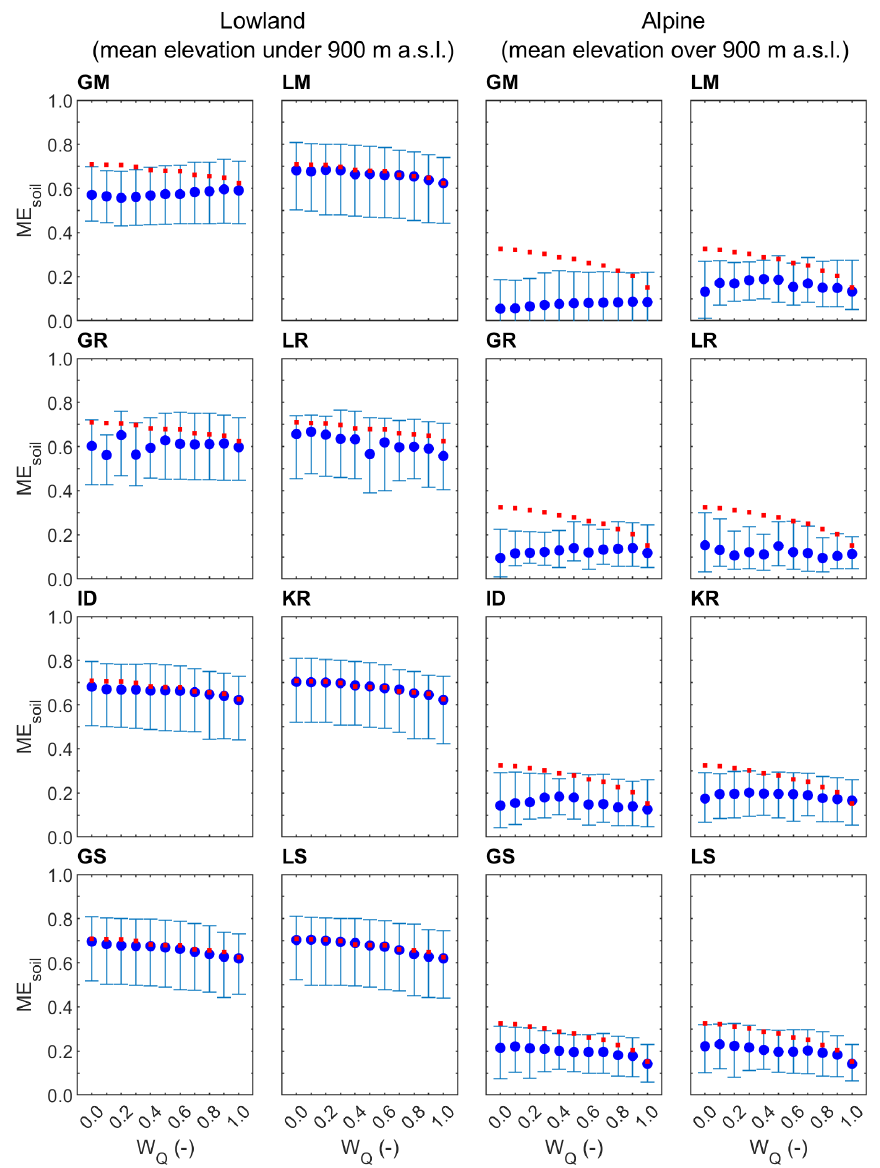
Figure 4. Median and regional scatter of the leave-one-out soil moisture correlation (Eq. 8) obtained by eight groups of parameter transfer methods and 11 calibration weights for lowland (94) and alpine (119) catchments in the calibration (2007–2010; blue symbols) period. Blue circles represent the median and whiskers the 25% and 75% quantiles of the leave-one-out efficiency. Red symbols show the median of the at-site soil moisture